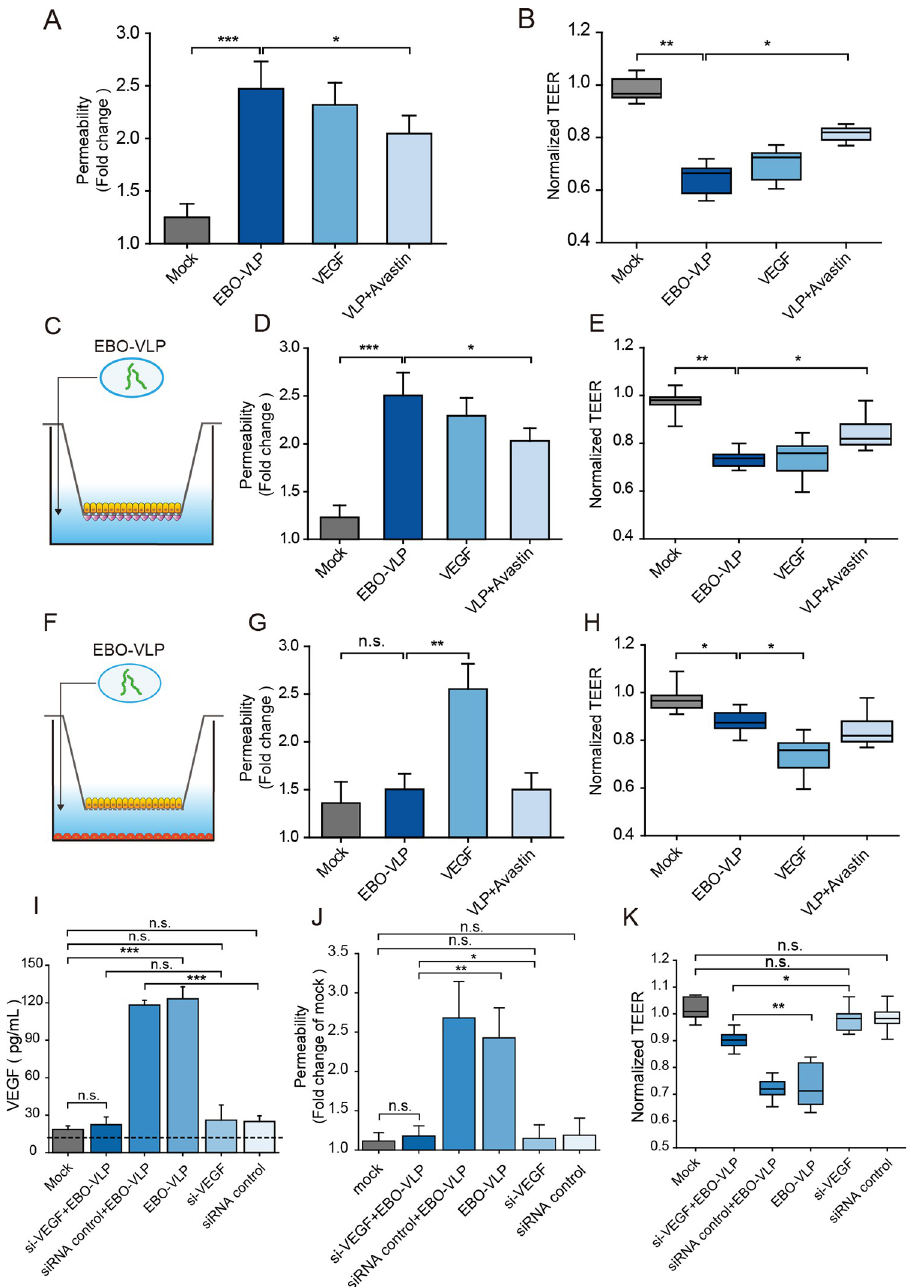
Fig 4. EBO-VLP causes iBRB breakdown through pericytes secretion of VEGF. (A-B) Integrity of the tri-culture iBRB model after EBO-VLP, EBO-VLP + Avastin and VEGF treatment. Na-F permeability (A) and the TEER values (B) of the iBRB model were examined 48 h after EBO-VLP administration. TEER values were normalized to those of iBRB models themselves before EBO-VLP administration. The box and the whisker present the median ± percentiles (25–75%) and range, respectively. The fold change of permeability compared with iBRB model itself before EBO-VLP administration is presented as the mean ± standard deviation. All values were determined in ten independent experiments. (C) Experimental schematic showing the addition of EBO-VLPs to the iBRB co-culture model of HREC and HRP. (D-E) Integrity of the iBRB co-culture (HRECs and HRPs) model after EBO-VLP, EBO-VLP + Avastin and VEGF treatment. Na-F permeability (D) and the TEER values (E) of the iBRB model were examined after 48 h of treatment. TEER values were normalized to those of iBRB models themselves before EBO-VLP administration. The box and the whisker present the median ± percentiles (25–75%) and range, respectively. The fold change of permeability compared with iBRB model itself before EBO-VLP administration is presented as the mean ± standard